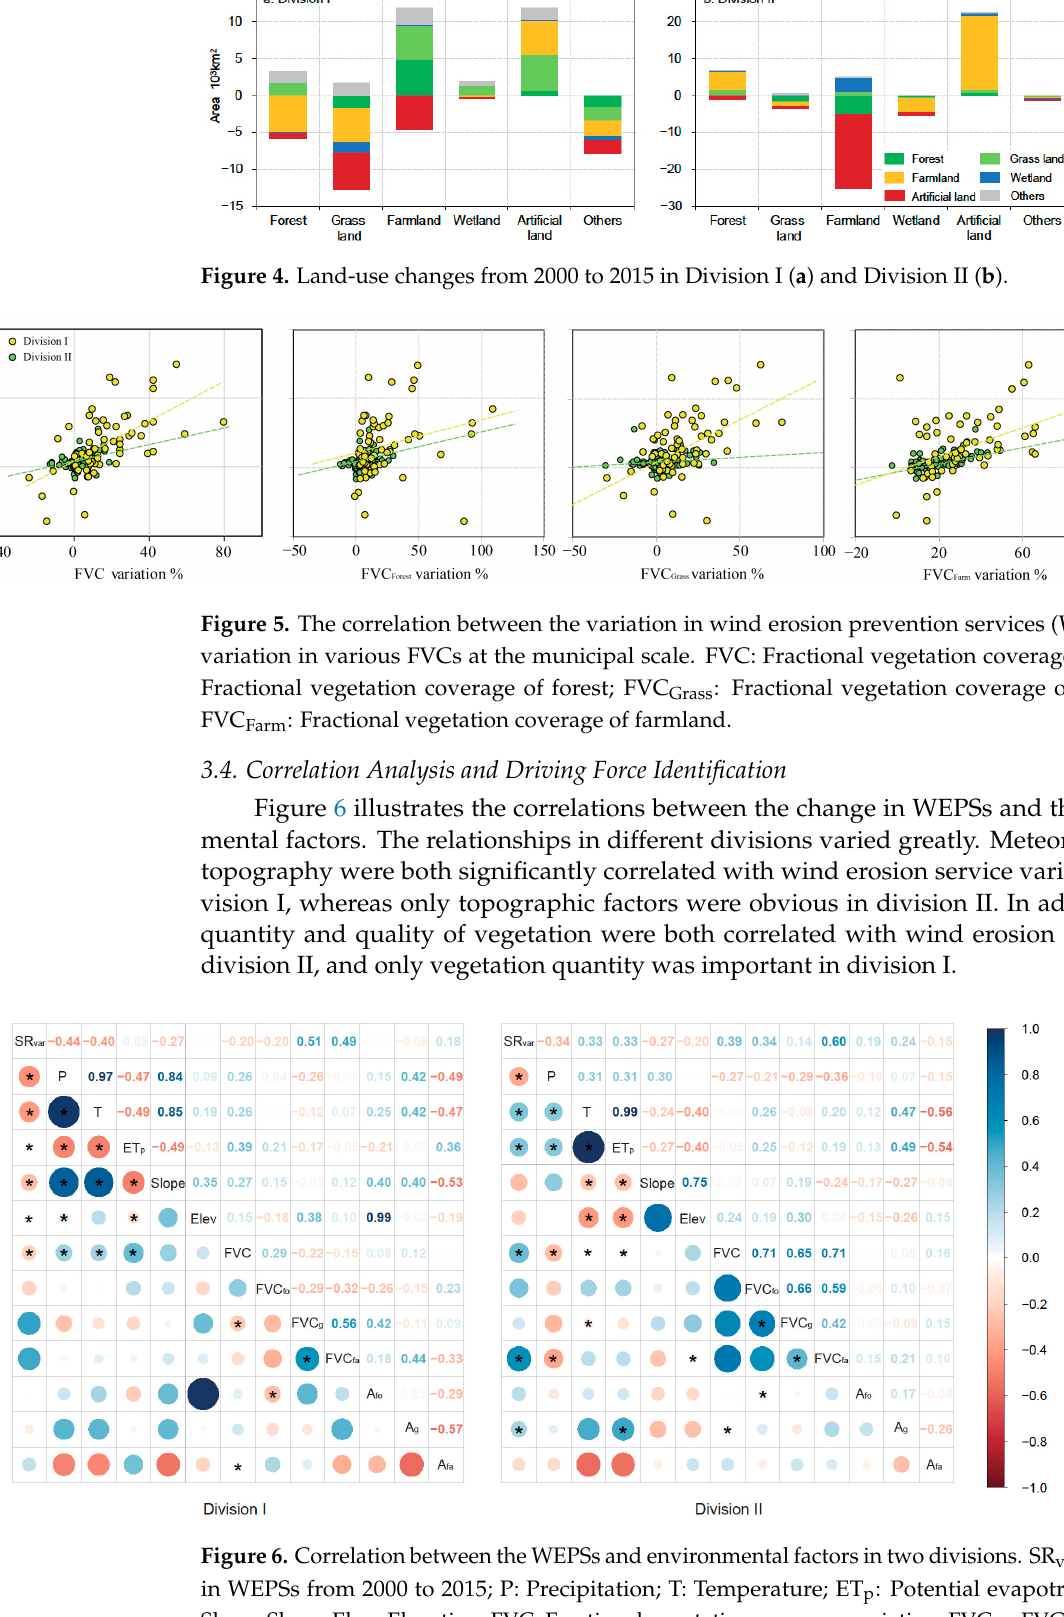
Figure 4. Land-use changes from 2000 to 2015 in Division I ( a ) and Division II ( b ).